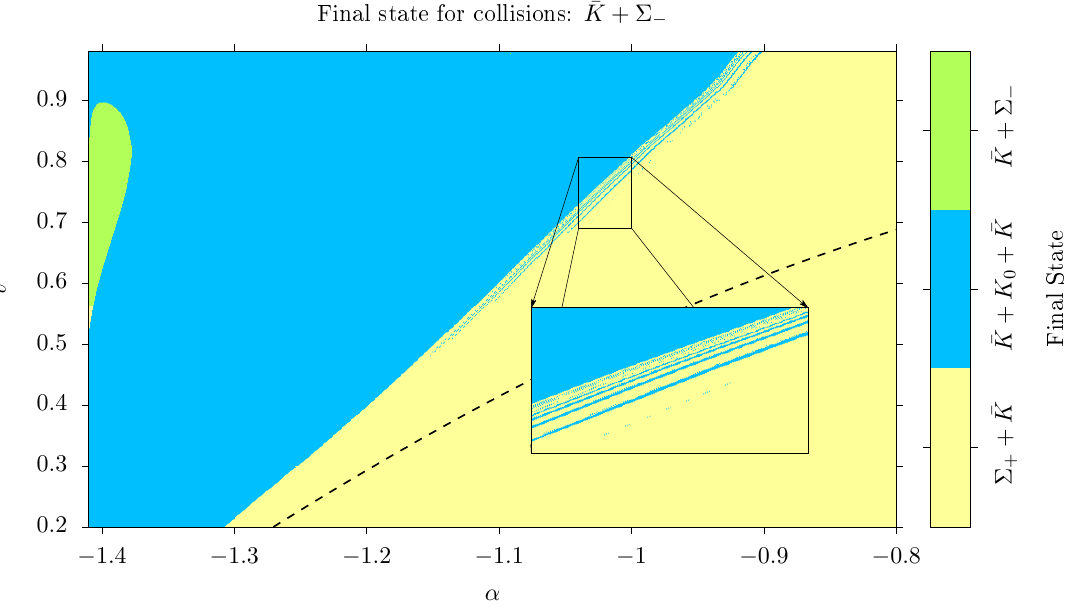
Figure 16 . Final states in the antikink-impurity collisions.